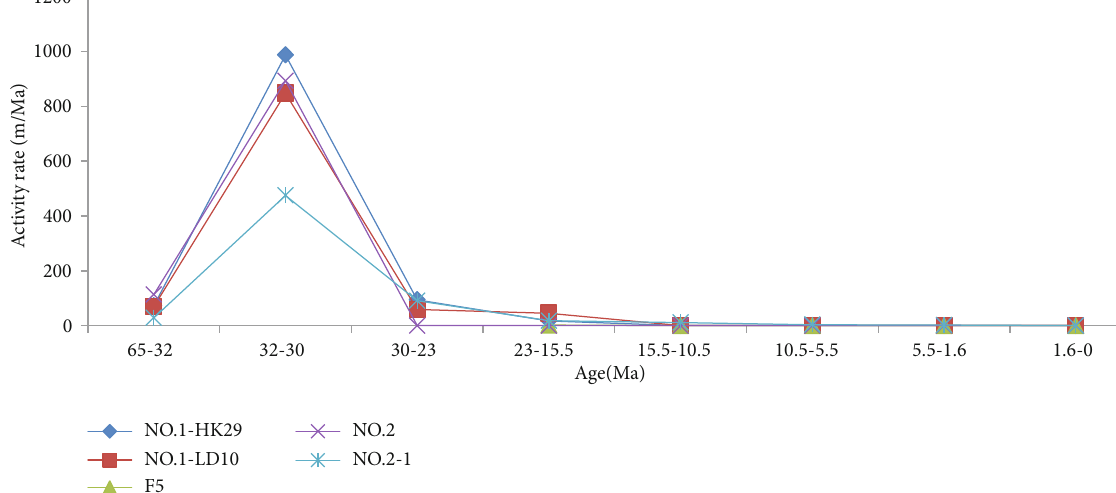
Figure 10: Vertical fault activity rates. Because the T100-T80 interfaces are not included in most of our 3D seismic data, we use the 2D seismic data shown in Figure 2 near the No. 1 and No. 2 faults to calculate the activity rates of the faults during their sedimentary periods. Because fault F5 cannot be identi fi ed in the 2D seismic data, we calculate the F5 fault activity rates after 23Ma using 3D seismic